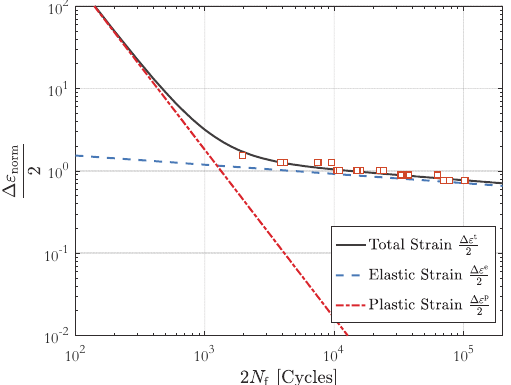
Figure 4: Strain-life curve used for model